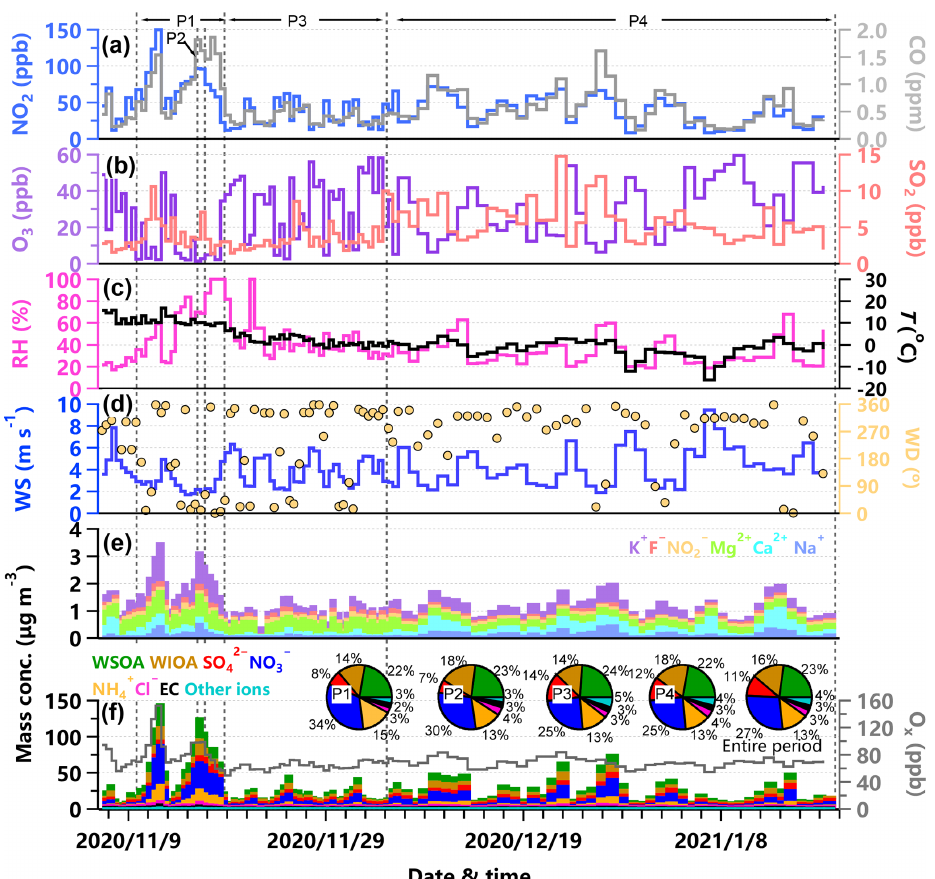
Figure 1. Time series of (a) NO 2 and CO, (b) O 3 and SO 2 , (c) relative humidity (RH) and temperature ( T ), (d) wind speed (WS) and wind direction (WD), (e) mass concentration of K + , F − , NO − NH + , Cl − , EC and other ions (sum of K + , F − , NO − 4 composition pie charts of the four periods and the entire